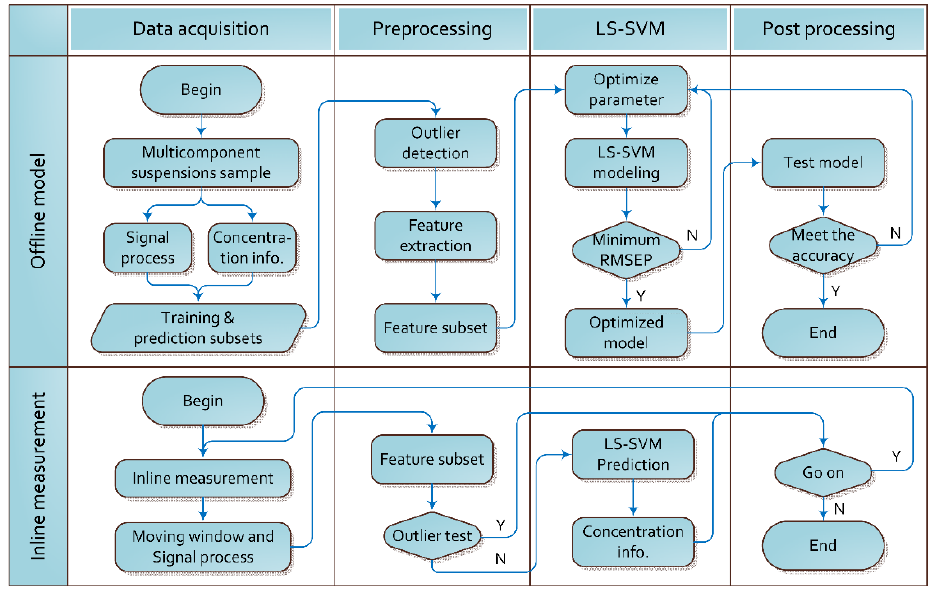
Figure 2. A flow chart of the whole process of modeling and inline